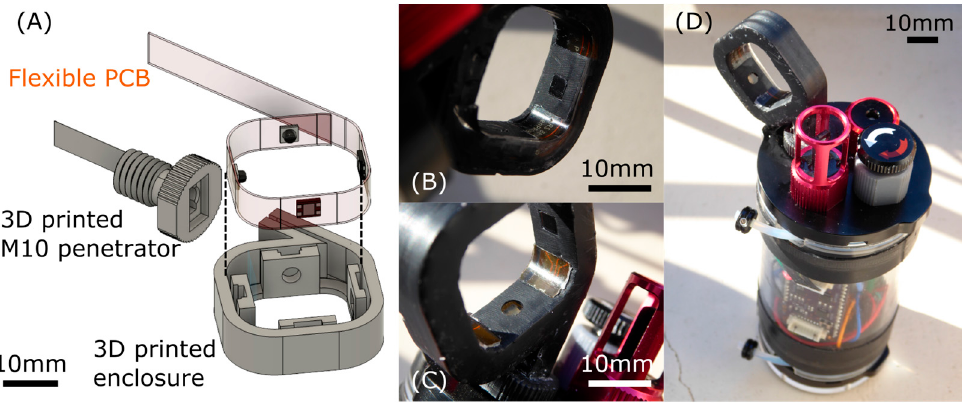
Figure 4. ( A ) CAD illustration of the GLI-2 sensor, with the flexible PCB hosting the two IR LEDs and the two photodiodes, the 3D-printed enclosure, and a 3D-printed M10 penetrator that makes the sensor compatible with Blue Robotics waterproof enclosures. ( B , C ) Close-up pictures of a photodiode and an LED optical port, respectively, after the PMDS overmolding step, to illustrate the good transparency and optical properties obtained with our method. ( D ) Implementation for in situ deployment with the electronics and LiPo battery protected behind a Blue Robotics two-inch diameter enclosure, showing the GLI-2 sensor head as well as additional pressure (depth) and temperature sensors.